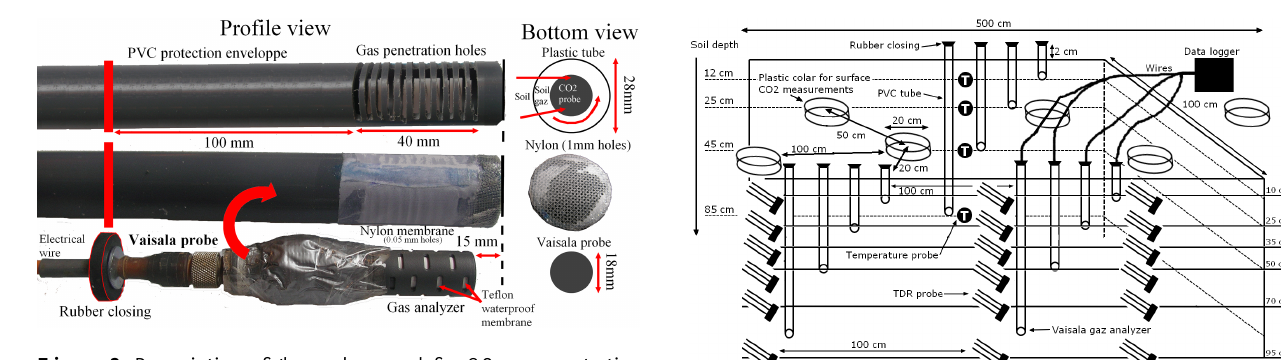
Figure 3. Description of the probes used for CO 2 concentration measurements inside the soil.